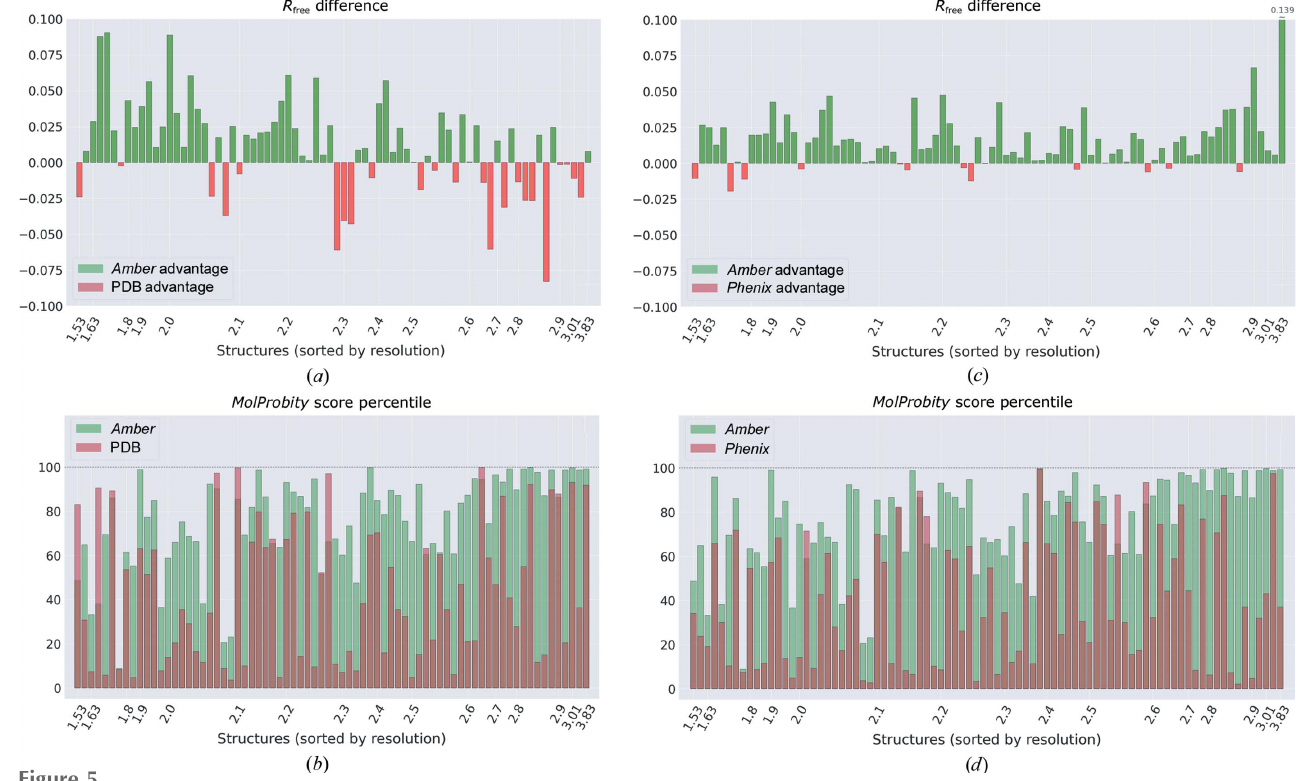
Figure 5 Summary of the refinement results starting from the scrambled models. All data shown in these graphs are also tabulated in Supplementary Table S3. ( a ) Difference in R free values between the original PDB depositions and the structures obtained through Amber -based refinement of the S-models. The data are from 74 test-set structures where R free is reported as part of the PDB deposition (sorted in this plot according to the crystallographic resolution). A green color indicates that the Amber -refined structure is superior to the original PDB structure and a red color indicates that the Amber -refined structure is inferior to the original PDB structure. ( b ) MolProbity score percentiles for the structures obtained through Amber -based refinement of the S-models (semi-transparent green bars) and the original PDB structures (semi-transparent red bars). Of note, the MolProbity scores of the Amber -refined structures are somewhat adversely affected by the addition of ordered water (see Fig. 2): before this step the average MolProbity score percentile is 86th, while after this step it drops to 76th. ( c ) Difference in R free values between the structures obtained through Phenix - and Amber -based refinement of the S-models. The data are from 84 test-set PDB entries. An exceedingly high (cid:2) R free of 0.139 (rightmost bar in the plot) reflects the failure of Phenix for this particular structure. ( d ) MolProbity score percentiles for the structures obtained through Ambe r- and Phenix -based refinement of the